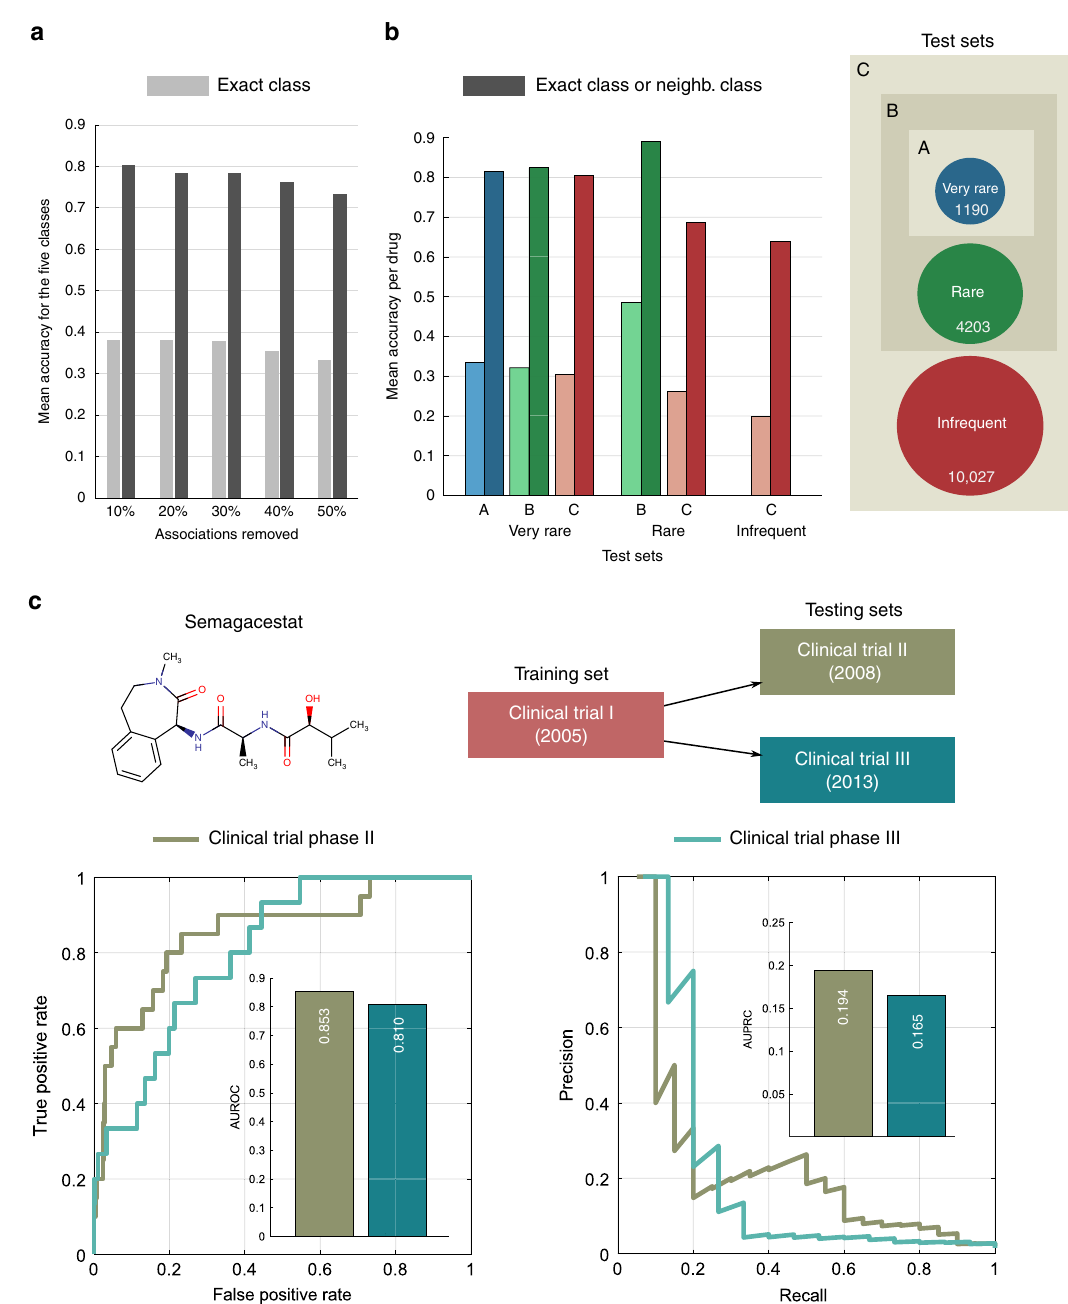
Fig. 4 Evaluation of our method on single drugs. a Mean accuracy at predicting the exact class (light grey) and the exact class or one of the neighbouring classes (dark grey) for varying percentages of randomly chosen associations. b Mean accuracy at predicting the exact class (light colour) and the exact class or one of the neighbouring classes (dark colour) for test sets A, B and C. Set A (blue bars) = 1190 very rare associations, 126 drugs; set B (green bars) = set A + 4203 rare associations, 237 drugs; set C (red bars) = set B + 10,027 infrequent associations, 473 drugs. Each test set is represented with circles, circle size represents the number of associations in each test set. c A case study for the γ -secretase inhibitor Semagacestat, an investigational small molecule for the causal treatment of Alzheimer ’ s disease. Side effect frequencies from three chronologically different phases of randomised controlled trials were collected: phase I (2005), phase II (2008) and phase III (2013). Only 8 (2 frequent and 6 very frequent) associations from phase I were used to train the model and the remaining associations of phases II (13 frequent and 7 very frequent), and III (13 frequent and 2 very frequent) were used separately to test the model. Scores generated by the model for the 986 unobserved side effects were assessed against the known associations from phases II and III using the receiver-operating characteristic curve and precision-recall curves (inset bar plots of AUROC and